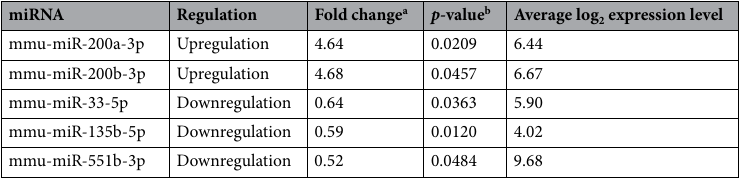
Table 1. Identification of five IPC-associated miRNAs. miRNA, micro ribonucleic acid; IPC, ischemic preconditioning; BCCAO, bilateral common carotid artery occlusion; MCAO, transient middle cerebral artery